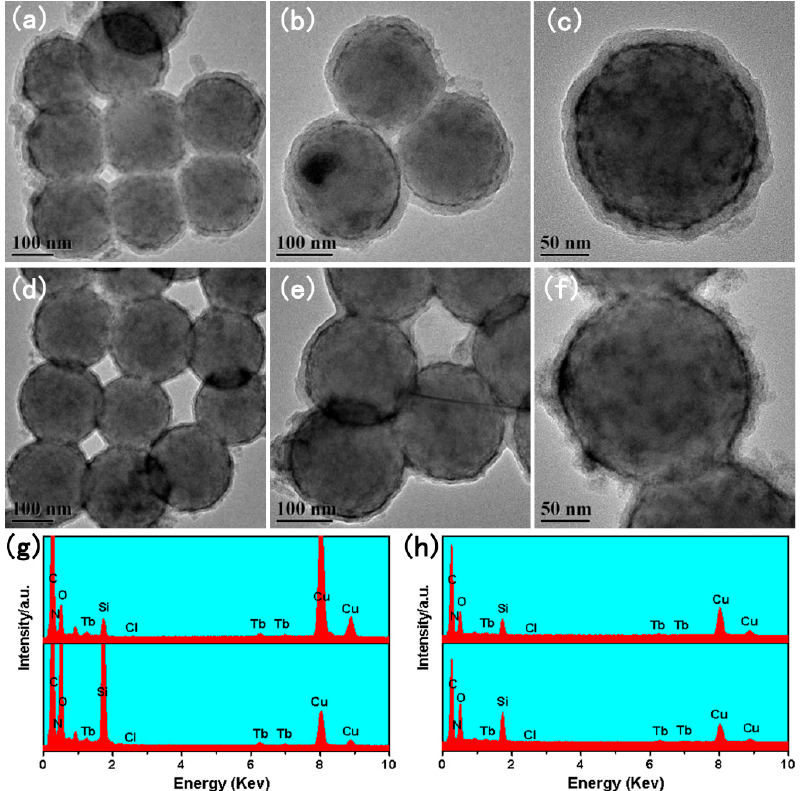
Figure 3. TEM images of SiO 2 @PMDA-Si-Tb@SiO 2 ( a – c ) and SiO 2 @PMDA-Si-Tb-phen@SiO 2 ( d – f ); EDX spectra of SiO 2 @PMDA-Si-Tb (top panel) ( g ), SiO 2 @PMDA-Si-Tb-phen (bottom panel) ( g ), and SiO 2 @PMDA-Si-Tb@SiO 2 (top panel) ( h ), and SiO 2 @PMDA-Si-Tb-phen@SiO 2 (bottom panel) ( h ).